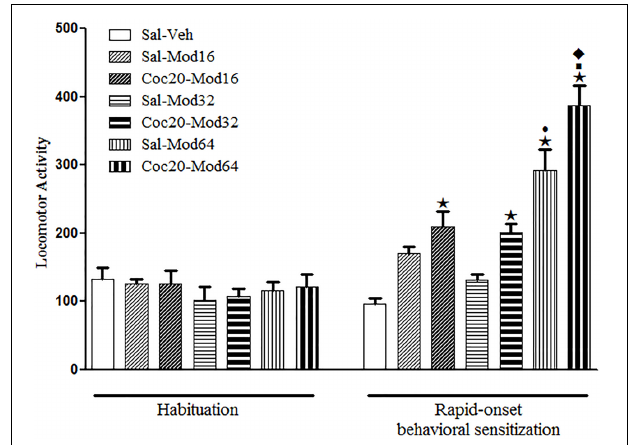
FIGURE 5 | Locomotor activity during the 3rd day of habituation and during the challenge session of the rapid-onset behavioral sensitization test with vehicle or different doses of modafinil. The animals received a priming injection of saline (Sal-) or 20 mg/kg cocaine (Coc20-), and after 4 h, a challenge injection of modafinil vehicle solution (-Veh), 16 mg/kg (-Mod16), 32 mg/kg (-Mod32), or 64 mg/kg (-Mod64) modafinil. After 30 min, the locomotor activity was measured for 10 min in the open field. Data are reported as mean ± SEM ( n = 12). (cid:70) P < 0.05 compared with the Sal-Veh group. (cid:4) P < 0.05 compared with the respective control group that received a priming injection of saline. • P < 0.05 compared with the Sal-Mod16 and Sal-Mod32 groups. (cid:117) P < 0.05 compared with all of the other